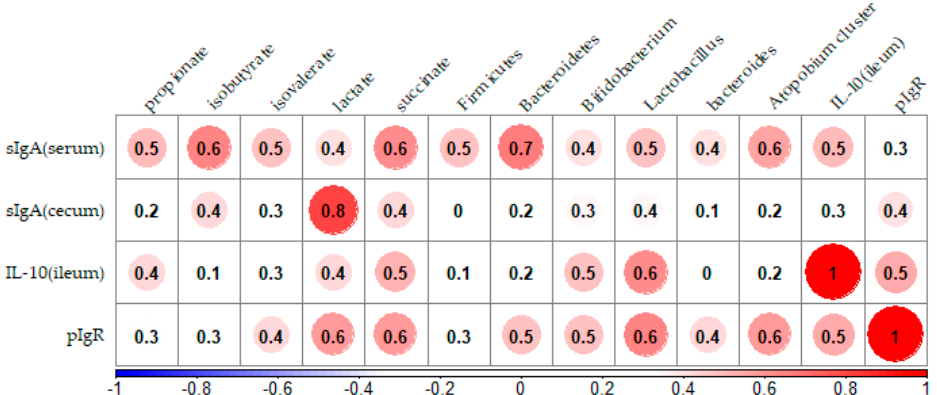
Figure 4. Result of the Spearman’s rank correlation coefficients analysis between the concentration of serum and cecum sIgA and parameters related to intestinal immunity. The values in the figure show the correlation, and red circles highlight a significantly positive correlation. sIgA, secretory immunoglobulin A; IL-10 , interleukin 10; pIgR , polymeric immunoglobulin receptor.